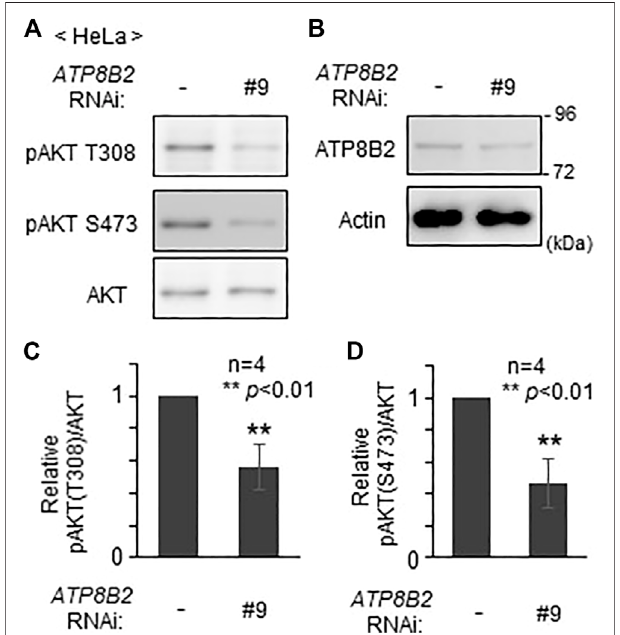
FIGURE 4 | Reduction of AKT activity by lowering ATP8B2 expression. (A,B) HeLa cells were transfected with siRNA (#9) against ATP8B2 and cultured for 72 h. Phosphorylation of AKT (A) and expression of ATP8B2 (B) were veri fi ed by immunoblot using the indicated antibodies. Actin was a loading control. (C,D) The amounts of pAKT T308 (C) and pAKT S473 (D) relativetototal AKTwererepresented( n =4). Dataindicate means ±SD.** p < 0.01, by Student ’ s t -test.